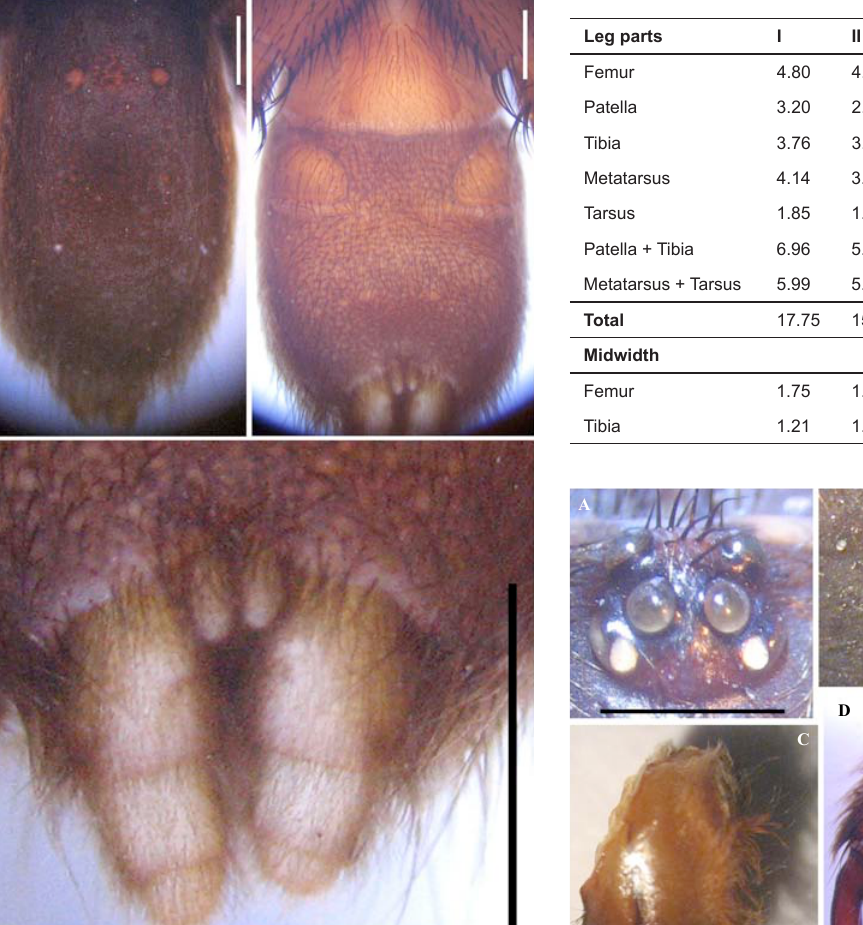
Table 1. Morphometry of legs and palp of S. arthrapophysis , male, ZSI/FBRC/A−25 (measurements in mm)